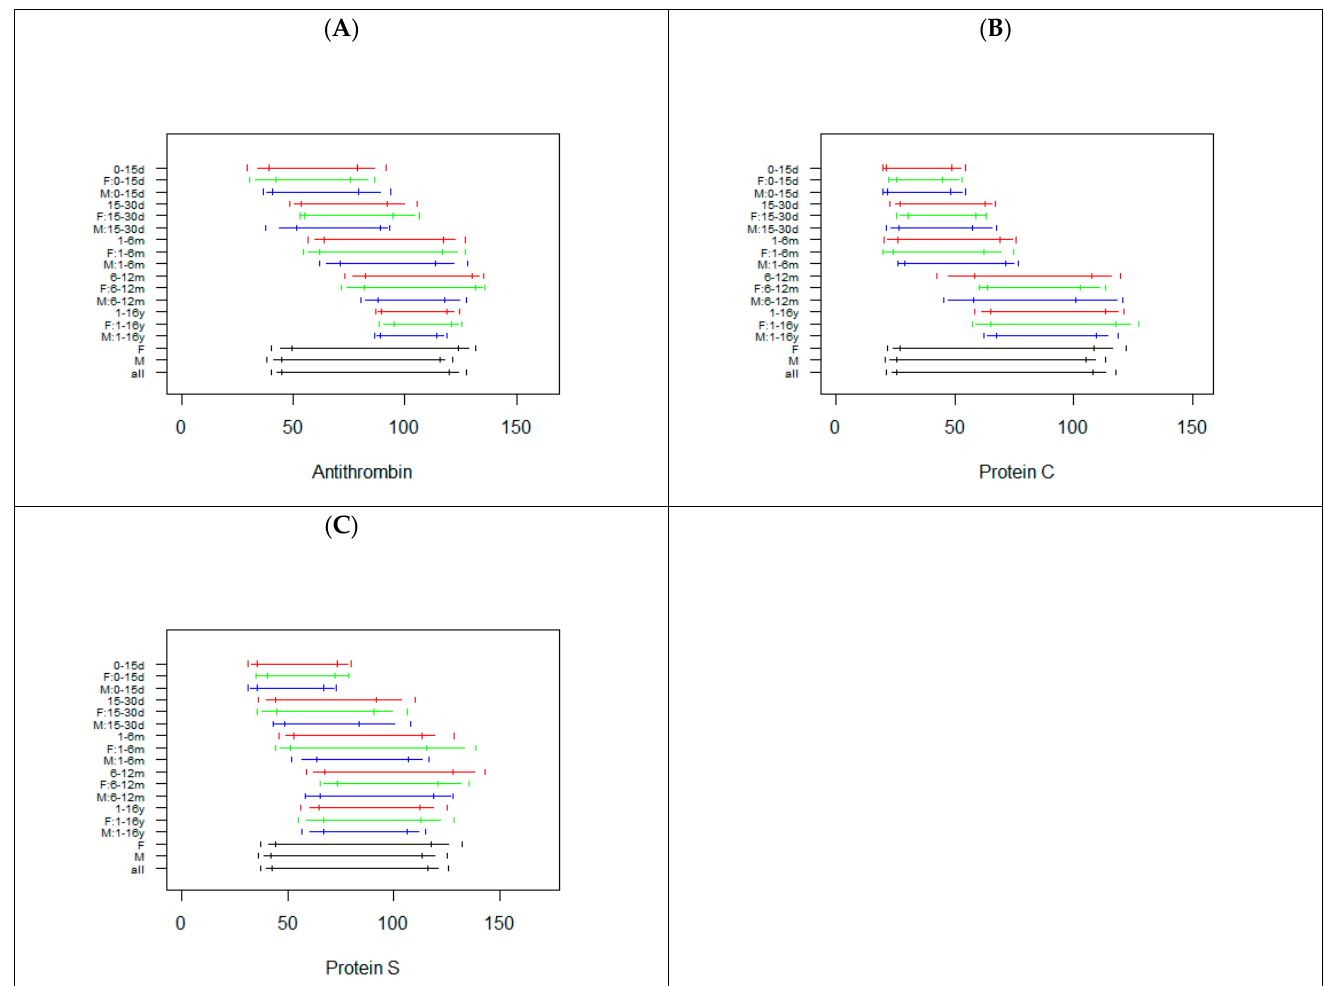
Figure 4. Reference intervals for Antithrombin ( A ), Protein C ( B ), and Protein S ( C ) in the subjects subgrouped by sex and age. The horizontal segments represent the RIs, while the vertical segments indicate the limits of the 90% confidence interval of the RIs. For each class, RIs are reported combining males and females (red) or, respectively, only in females (green) or males (blue). The last three RIs are calculated without taking into account age, in females, males, or in the whole sample. d = days, m = months, y = years, F = females, M =